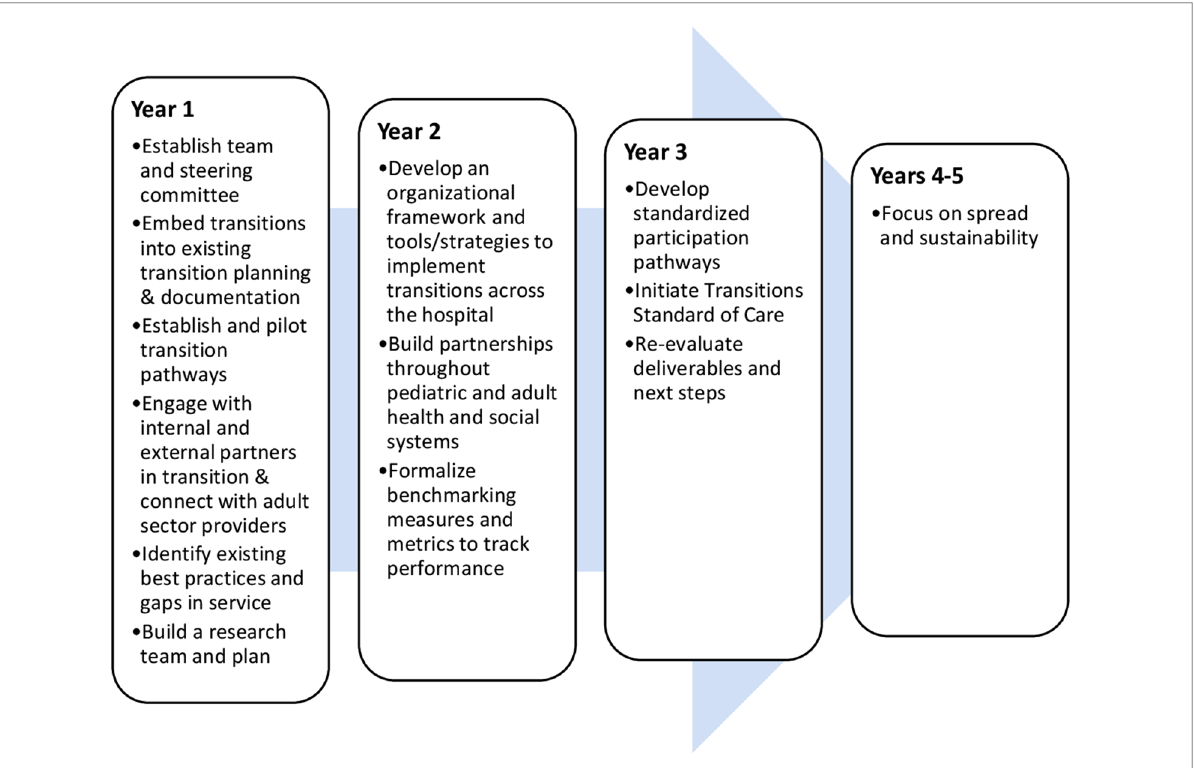
FIGURE 2 Yearly goals for the Transition